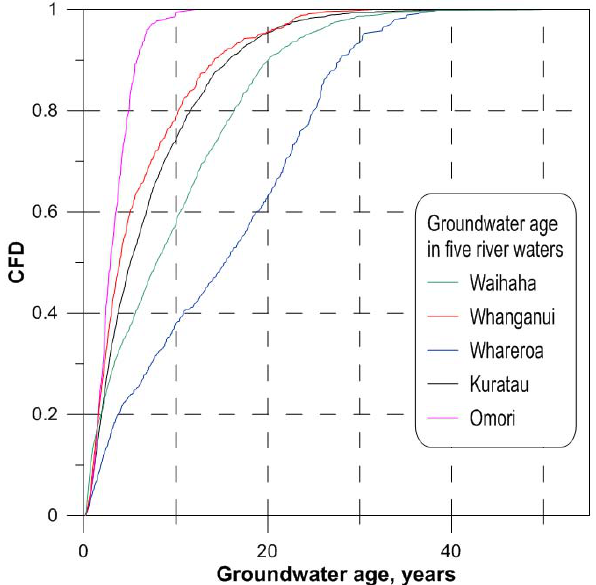
Fig. 5. Simulated groundwater age distributions from the tritium- calibrated MT3DMS model for the Waihaha River, Whanganui Stream, Whareroa Stream, Kuratau and Omori rivers near their out- flows into Lake Taupo.